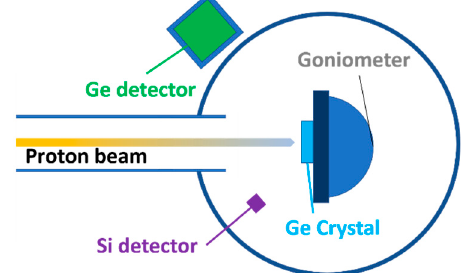
Figure 1. Experimental setup. A proton beam is delivered by the LNL-CN accelerator to a germanium single crystal installed onto a goniometer. Backscattered protons are detected through a silicon detector, while the γ -radiation is measured through a HPGe